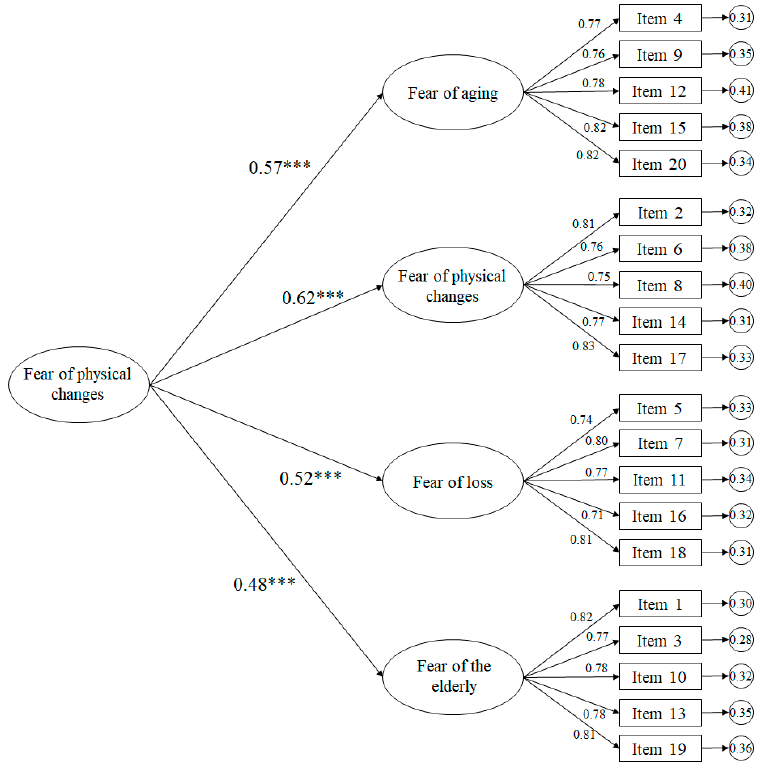
Figure2. Confirmatoryfactoranalysis(High-Order). Theellipsesrepresentthefactorsandtherectangles Figure 2. Confirmatory factor analysis (High-Order). The ellipses represent the factors and the rectangles represent the different items. The residual variances are shown in the small circles. *** p < represent the di ff erent items. The residual variances are shown in the small circles. *** p < 0.001.